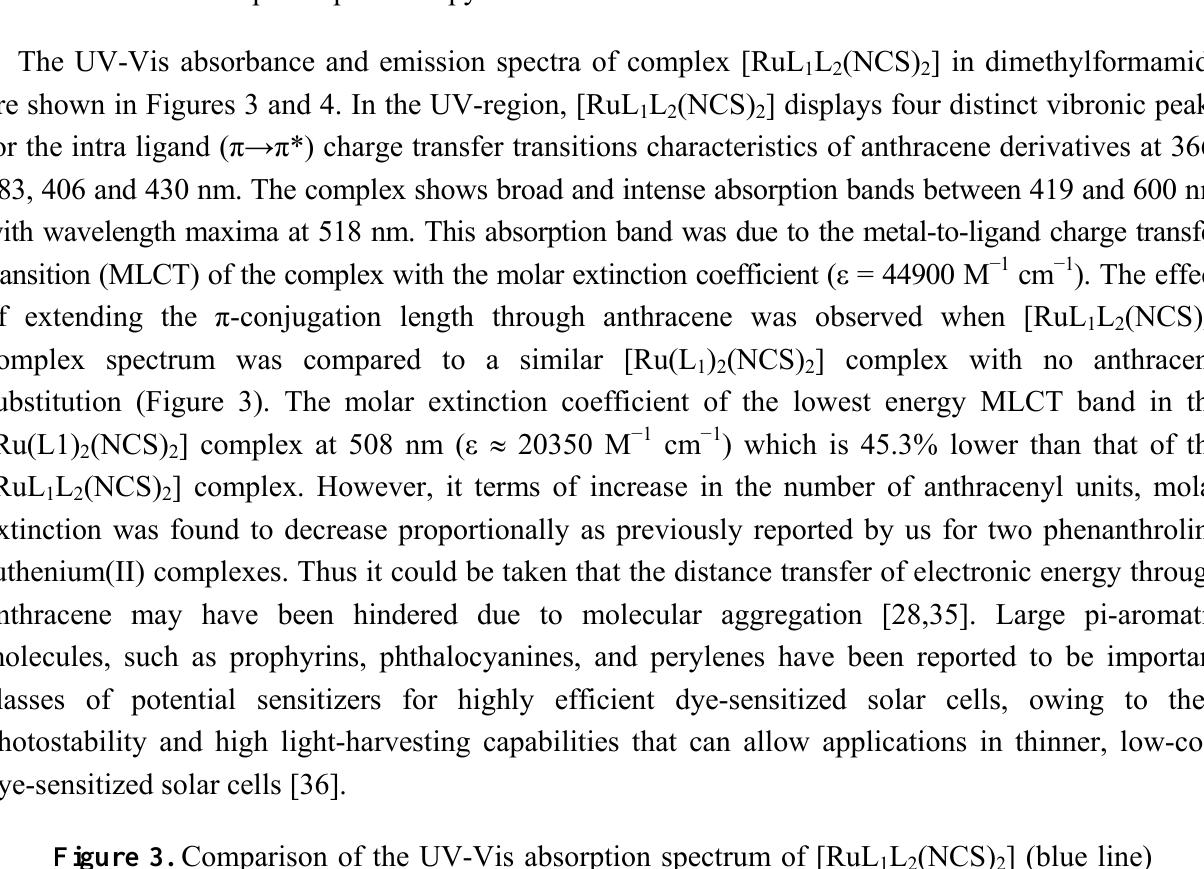
L (NCS) ] (blue line) 1 2 2